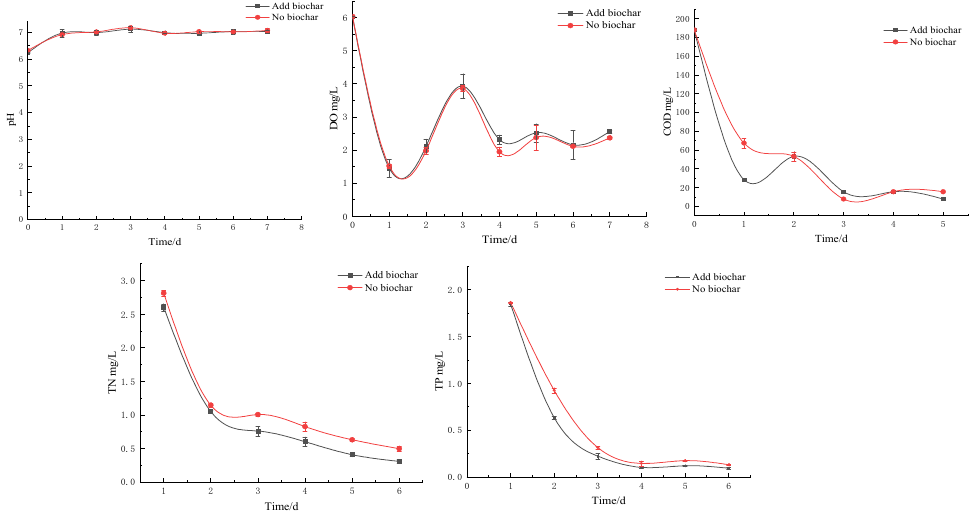
Figure 5. Comparison between with and without biochar addition in the variation of pH, DO, COD, TN, and TP of outlet water.